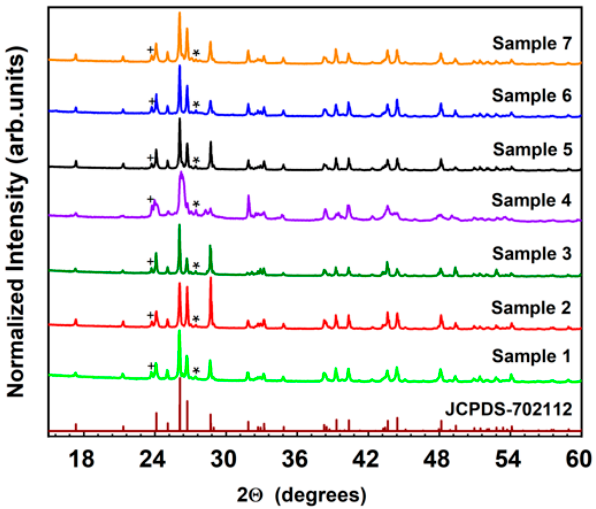
Figure 1. XRD patterns of Ba 0 . 98 SiO 3 :0.02Eu 3+ , 0.02R (R = Li + , K + and Na +